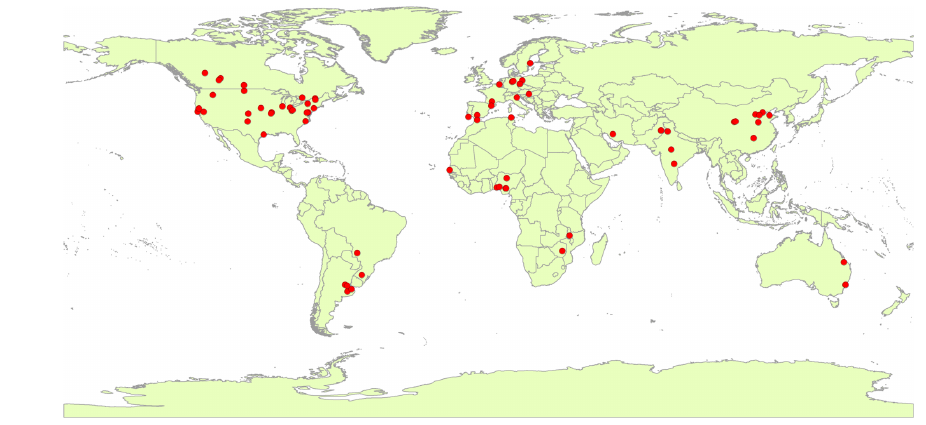
Figure 1. The geographical coverage of the 69 studies used in the meta-analysis.